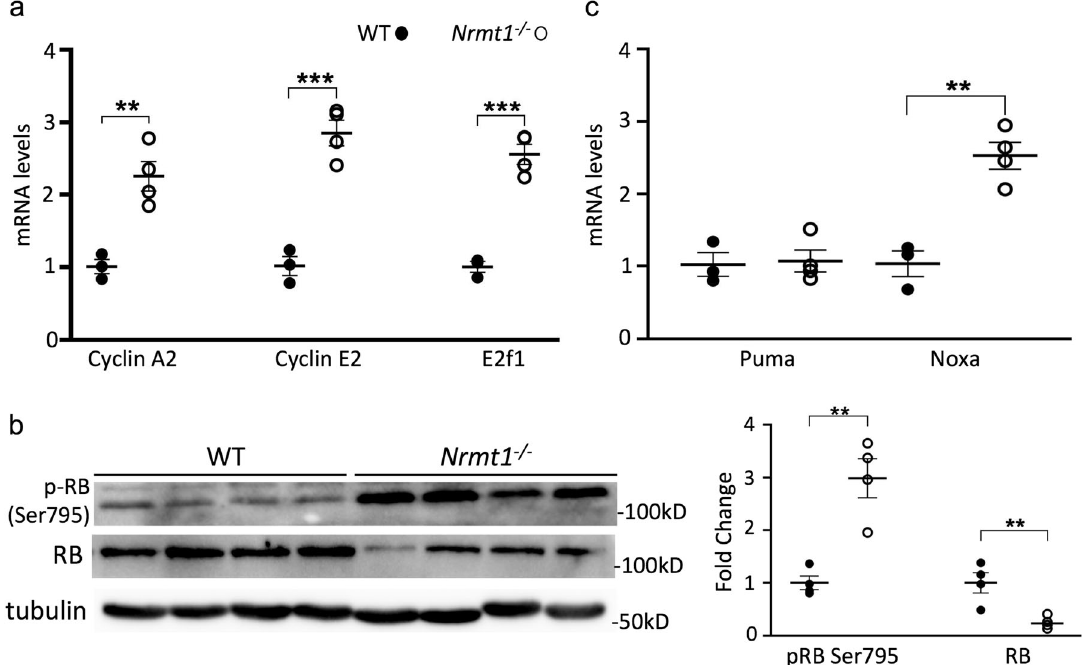
Fig. 7 Nrmt1 − / − mice show misregulation of RB function. a mRNA levels of RB target genes cyclin A2, cyclin E2, and E2f1 are signi fi cantly increased in Nrmt1 − / − mice. b In addition, RB phosphorylation at serine 795 (p-RB Ser795) signi fi cantly increases but overall RB protein levels signi fi cantly decrease. Quanti fi cation of Western blots shown at the right. All samples normalized to tubulin loading control. c qRT-PCR analysis indicates apoptosis is not driven through increased expression of the RB target Puma but instead by the RB target Noxa . ** p < 0.005 and *** p < 0.0005 as determined by unpaired t -test, n = 3 – 4. Error bars represent mean ±